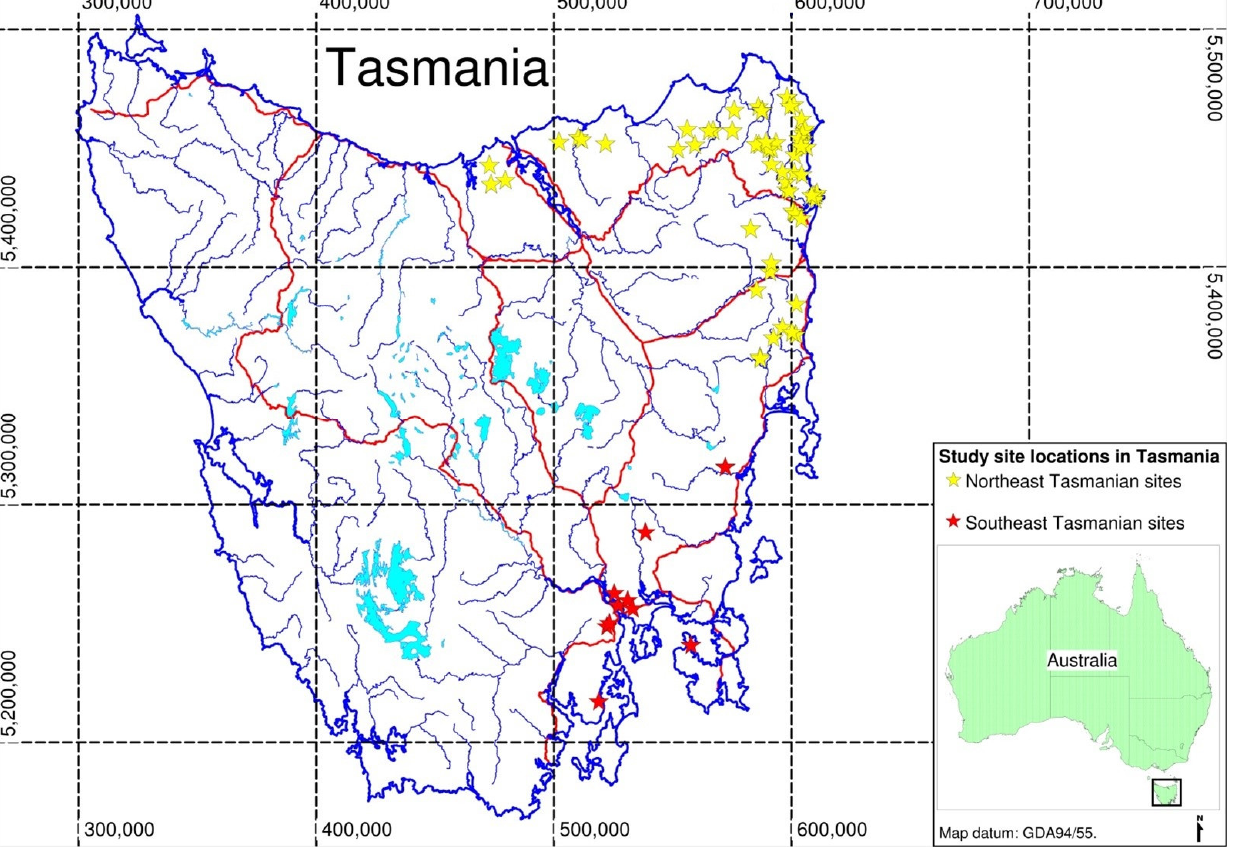
Figure 1. Study site locations in Tasmania.